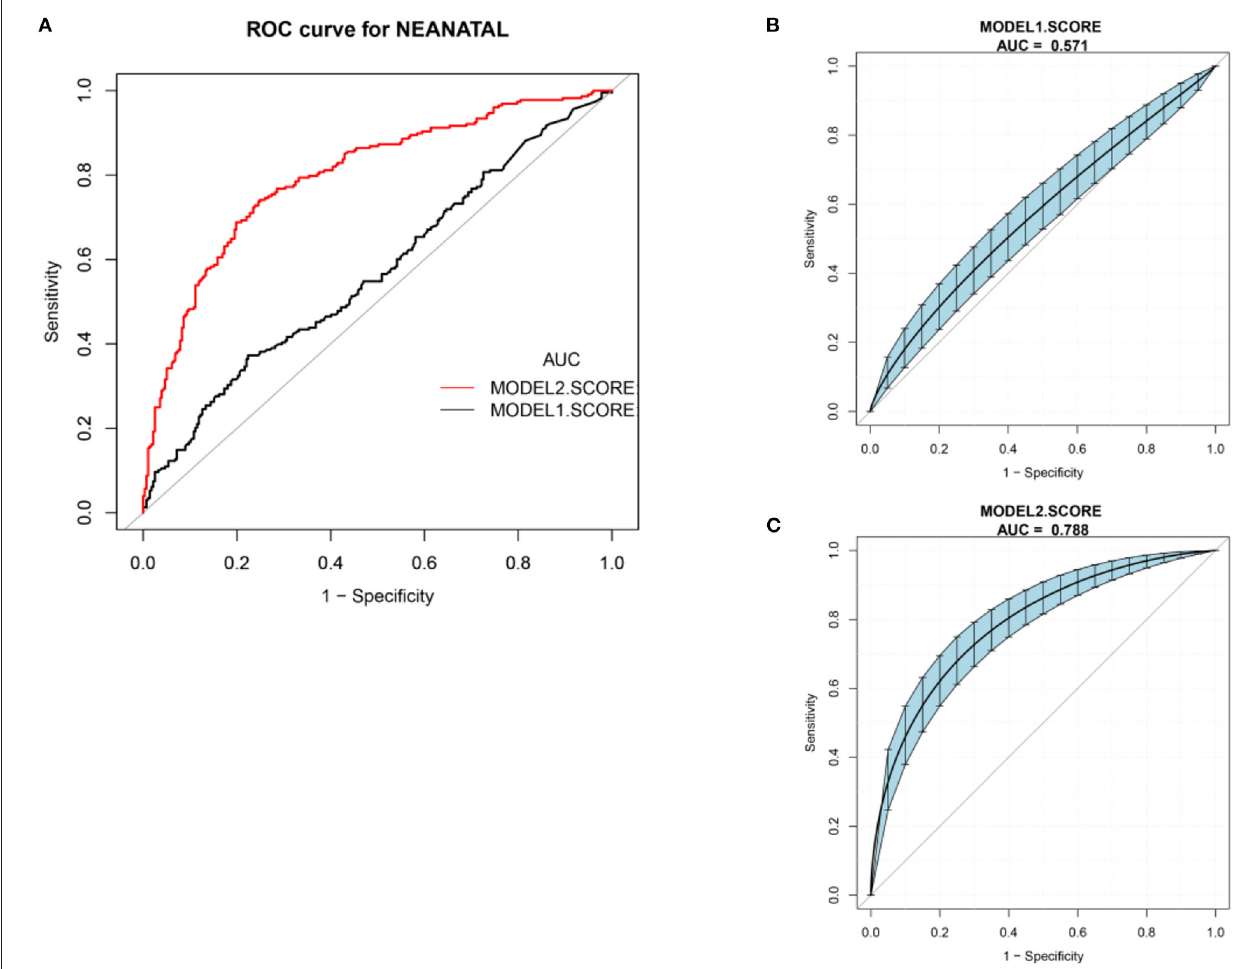
FIGURE 2 | ROC curve. (A) Total ROC curve of model I and model II. (B) Model I AUC with a 95% confidence interval using 500 bootstrap re-sampling, 0.571 (95% CI, 0.523 to 0.622). (C) Model II AUC with a 95% confidence interval using 500 bootstrap re-sampling, 0.788 (95% CI, 0.751 to 0.825). higher risks of neonatal morbidity after PROM at home.